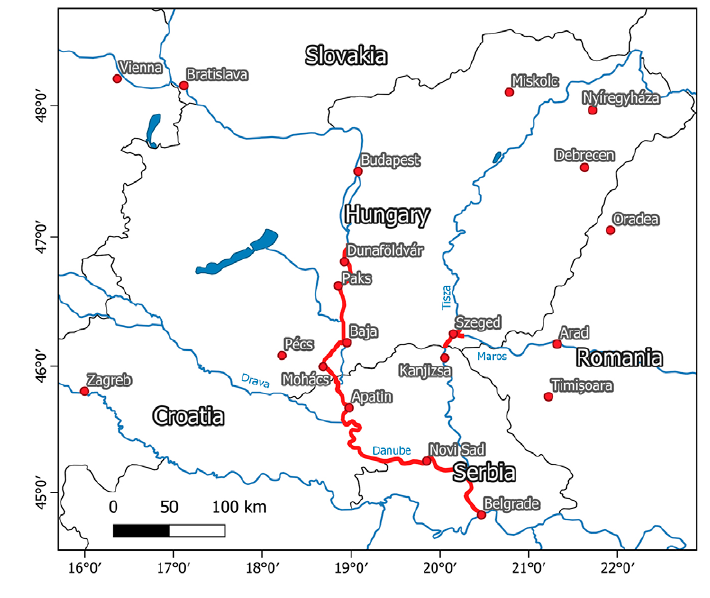
Figure 1. Study areas along the Danube and Tisza/Maros